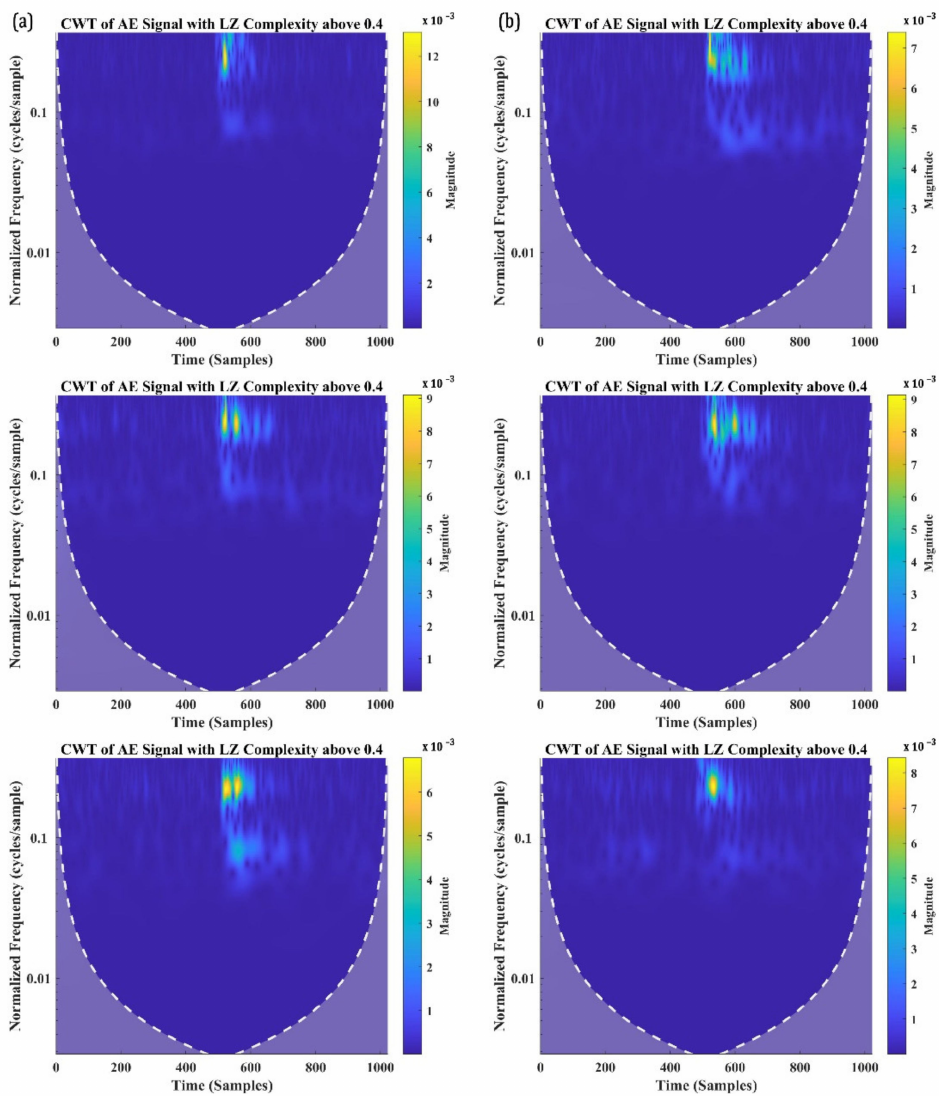
Figure 14. CWT of the AE signals with W.P-Freq above 350 kHz and LZ complexity above 0.4 recorded from SBS specimens tested at ( a ) 100 ◦ C and ( b ) 120 ◦